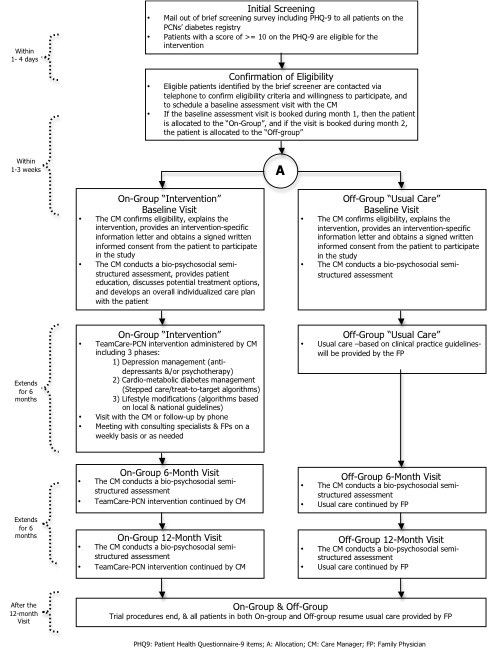
TeamCare-PCN Study Procedures.